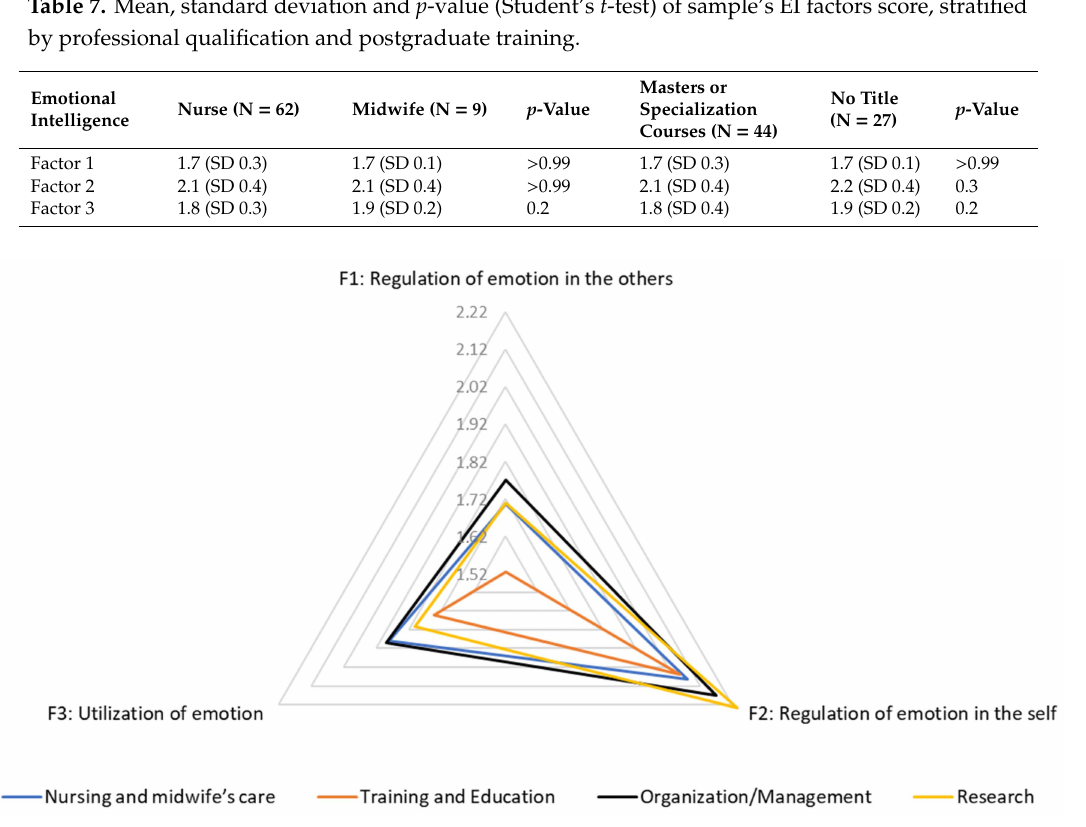
Figure 2. Graphical representation of emotional intelligence factors by training